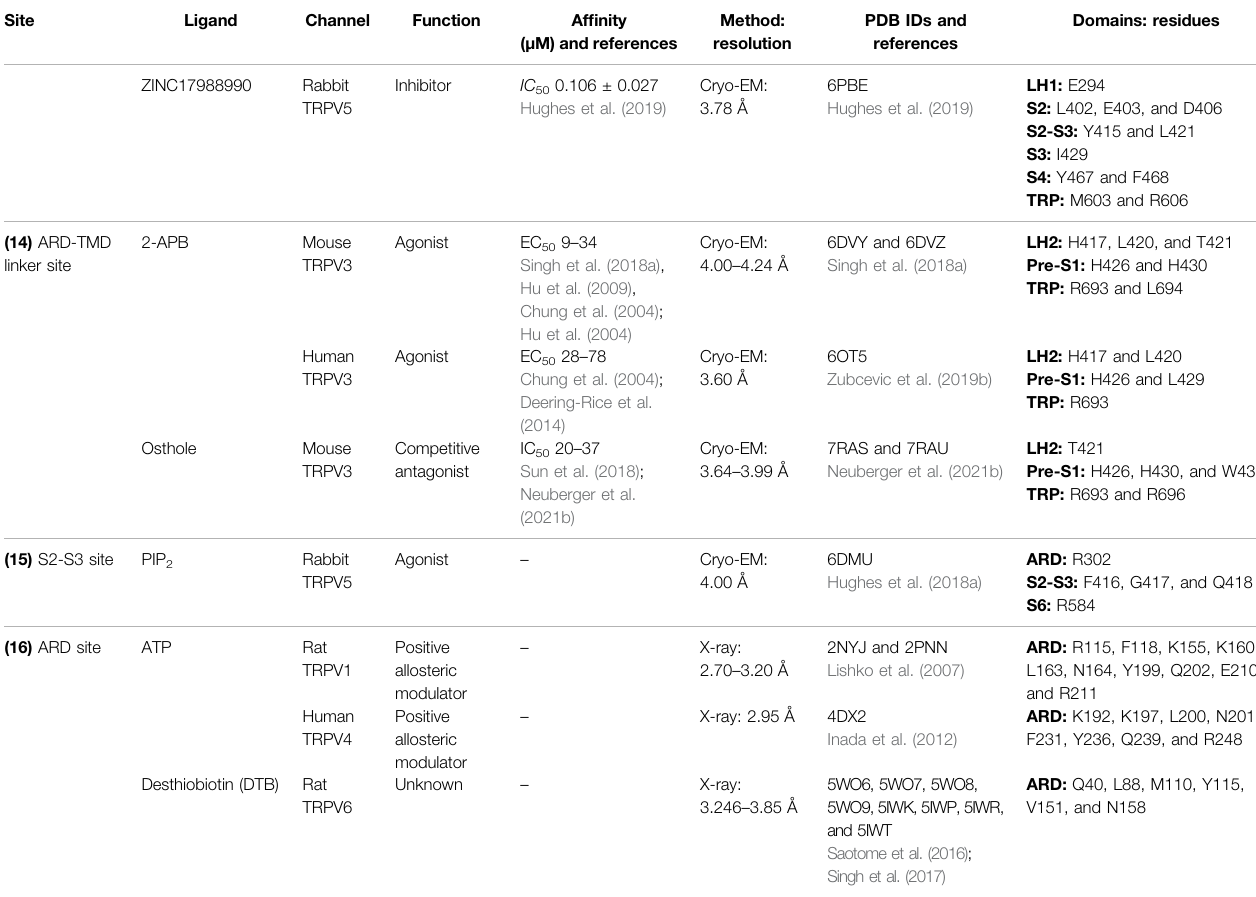
TABLE 1 | ( Continued ) Ligand binding sites in TRPV